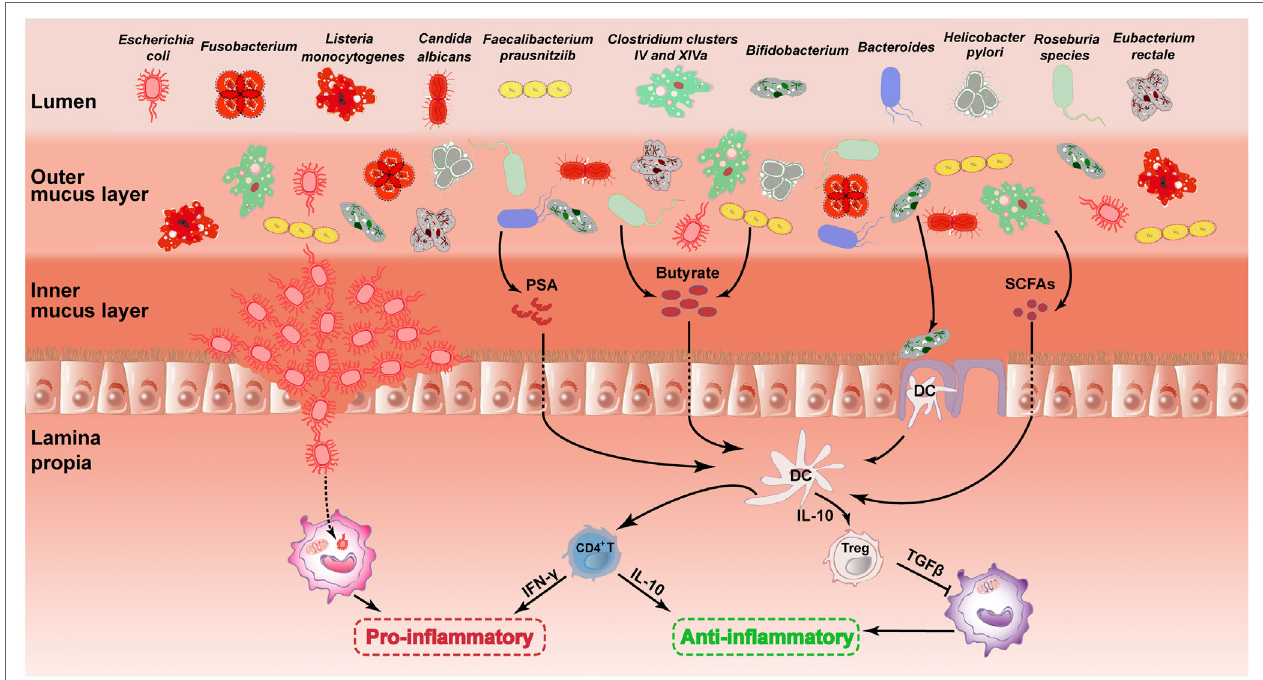
FigURe 1 | Role of the gut microbiota in the pathogenesis of UC. The picture describes the changes in the major intestinal microbiota in the UC and its influence on gastrointestinal. This illustration contains 11 types of intestinal microbiota and their changes mentioned in this review. The mechanisms underlying the effects of certain microbiota on the gastrointestinal are described. It includes microbiota acting on DC cells by secreting substances such as PSA, butyrate and SCFAs. Then, DC cells further act on CD4 + T cells or regulatory T (Treg) cells to inhibit inflammation. There are also mechanisms by which AIEC destroys the gut barrier and further induces inflammation. The first four species of microbiota are painted in dark red, representing harmful microbiota. The other seven species of microbiota are painted in other colors, representing healthy microbiota. UC, ulcerative colitis; DC, dendritic cell; PSA, polysaccharide A; SCFA, short-chain fatty acid; AIEC, adherent-invasive Escherichia coli